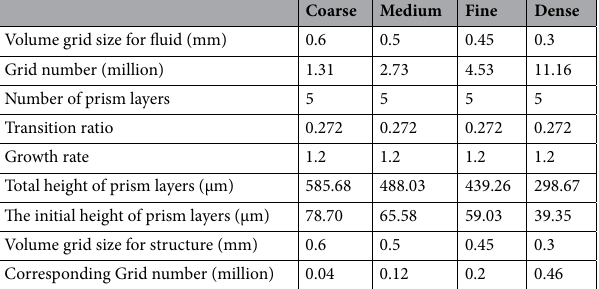
Table 1. Setting of calculational meshes in grid independence study. The height of the prism layers was determined by a transition ratio (0.272) of the height of the last prism and a growth rate (1.2).